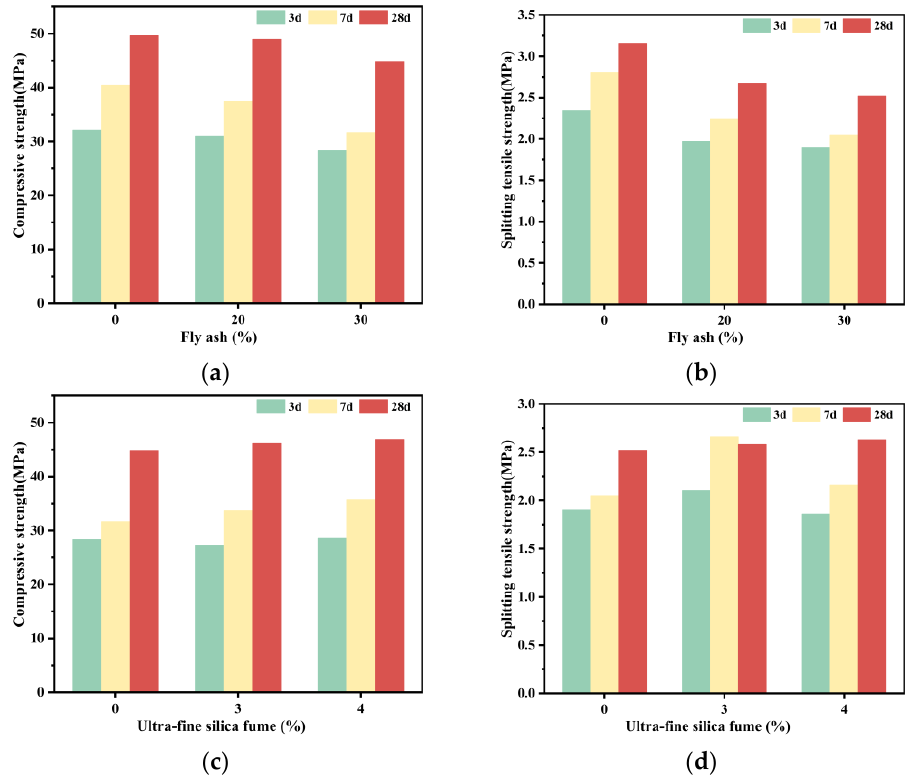
Figure 1. Influence of mineral admixtures on the mechanical properties of PMJC. ( a ) Influence of fly ash on compressive strength. ( b ) Influence of fly ash on splitting tensile strength. ( c ) Influence of ultra-fine silica fume on compressive strength. ( d ) Influence of ultra-fine silica fume on splitting tensile strength.